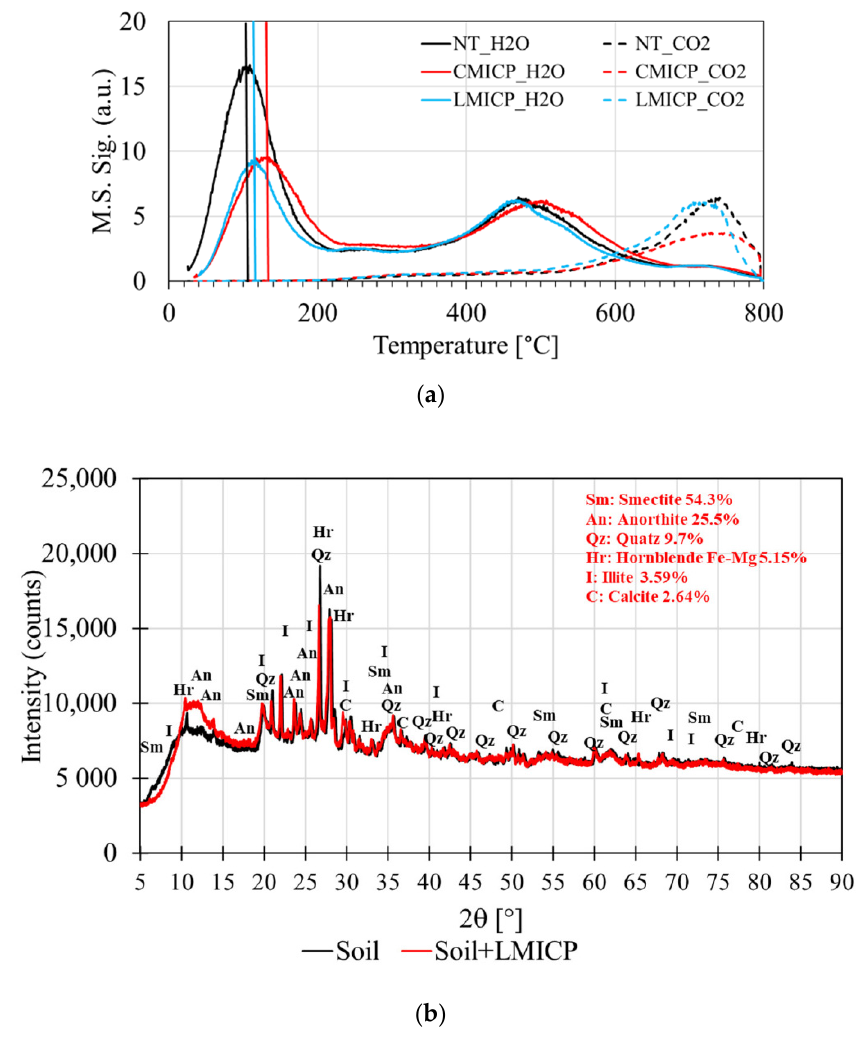
Figure 15. Analysis of treated and untreated Lampa clay: ( a ) temperature-programmed desorption, evaporation of water and CO 2 in atomic mass unit as a function of temperature; ( b ) XRD patterns (R wp = 2.9 GoF = 2.4).